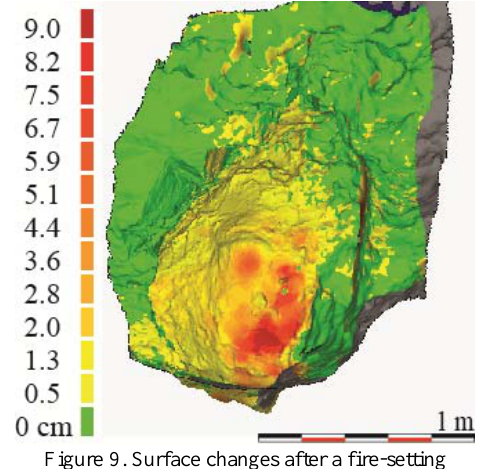
Figure 9. Surface changes after a